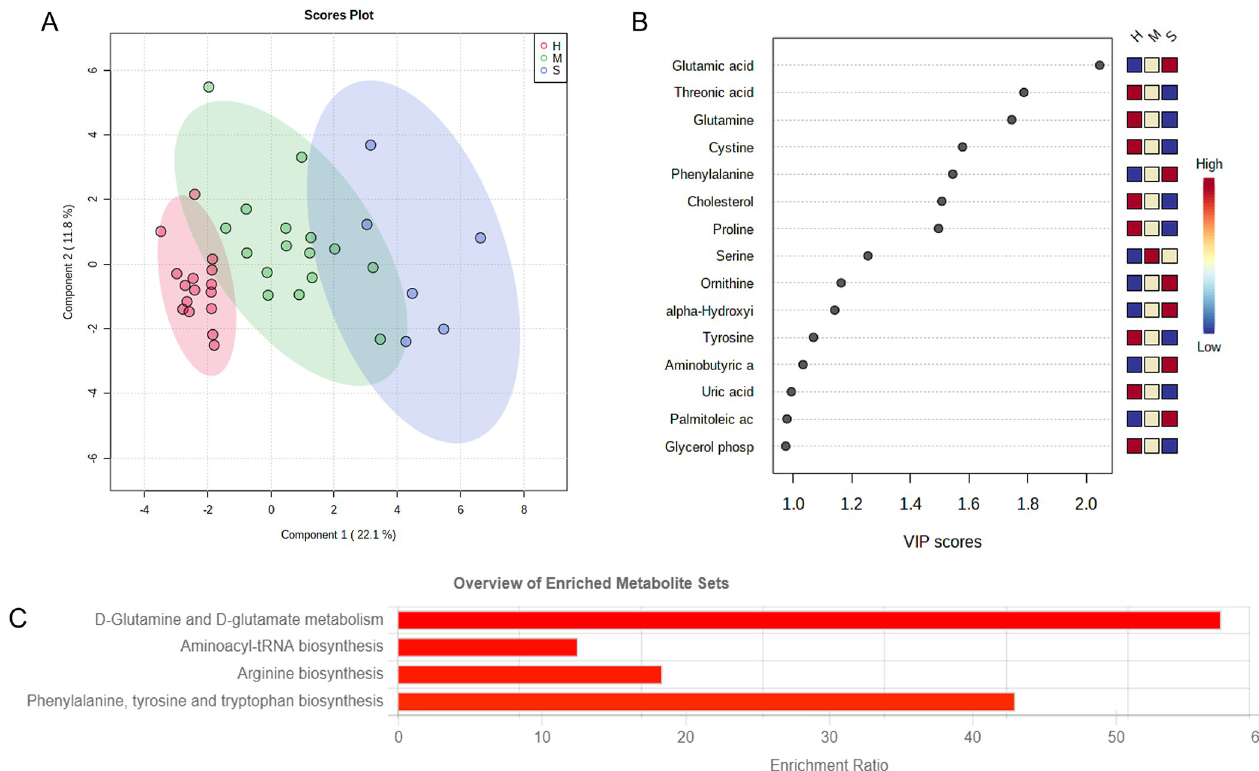
Fig 2. Partial least squares-discriminant analysis of COVID-19 patients. A. Score plot of PLS-DA analysis of healthy controls (H), mild/moderate (M), and severe (S) patients. B. Variable importance in the projection (VIP) values that better explain the differences between the groups; C. Enriched metabolite data sets (p < 0.05) for the VIP metabolites involved in COVID-19 severity clustering.